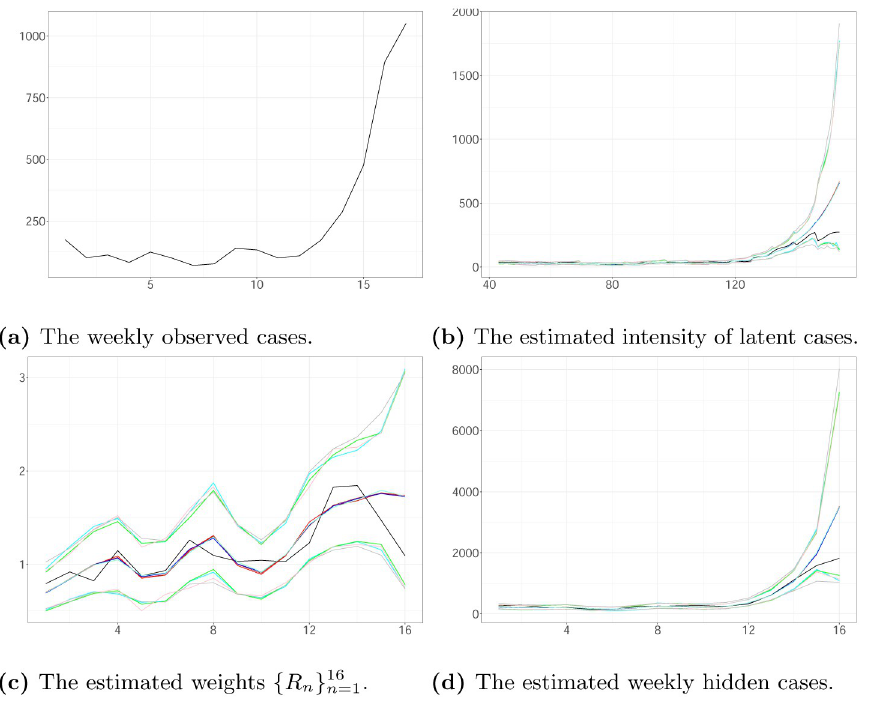
Fig 5. The weekly observed cases, the estimated intensity, the estimated reproduction number, the estimated weekly hidden cases using KDPF(median (red line); 99% CI (cyan line)), using APF (median (brown line); 99% CI (green dashed lines)), using PMMH (median (aquamarine line); 99% CI (grey dashed lines)), using BF (median (blue line); 99% CI (pink dashed lines)) and the true values (black line) in scenario C plotted against time. The vertical dotted lines show the beginning of each week in the period we examine. (a) The weekly observed cases. (b) The estimated intensity of latent cases. (c) The estimated weights f R g 16 . (d) The estimated weekly hidden cases. n n ¼ 1